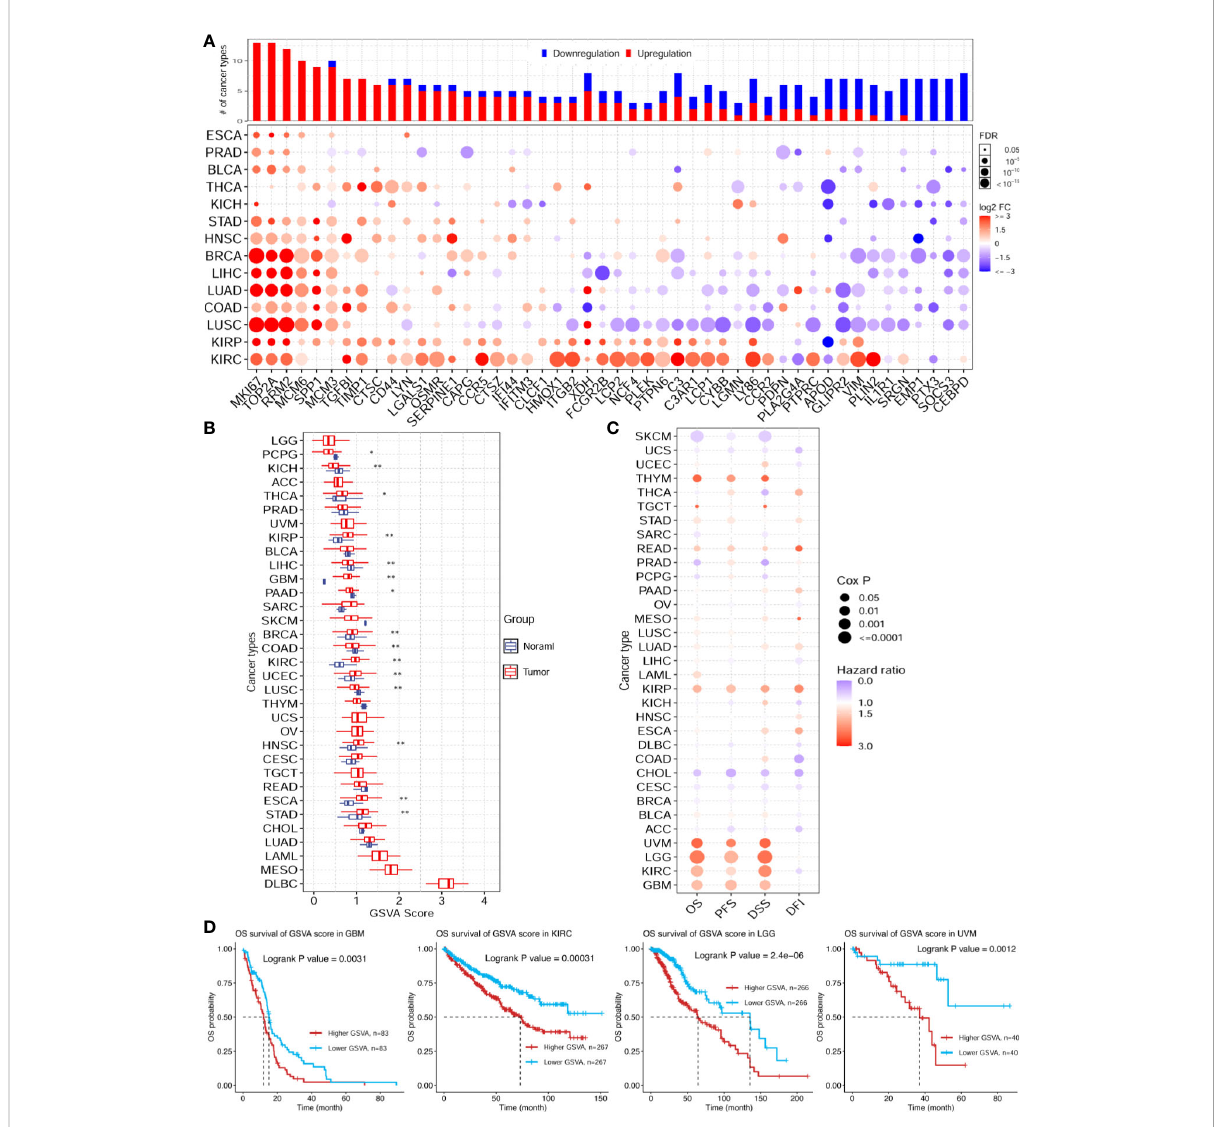
FIGURE 6 Pan-cancer genomic and prognostic analyses of the ischemic injury-associated genes. (A) Upregulation ( red ) and downregulation ( blue ) patterns of the ischemic injury-associated gene sets across different cancer types ( y -axis) compared to paired normal samples. The x -axis represents the 50 core brain ischemic injury-associated genes. The color intensity indicates the fold change, while the point size indicates the signi fi cance of the p -value. Upper bars show the frequency of cancer types, with upregulation ( red ) and downregulation ( blue ) for each brain ischemic injury- related gene. (B) Gene set variation analysis (GSVA) scores of the ischemic injury-associated gene set in each cancer type ( n = 3). * p < 0.05, ** p < 0.01. (C) Expression of the ischemic injury-associated genes correlated with the overall survival (OS), progression-free survival (PFS), disease-speci fi c survival (DSS), and disease-free survival (DFI) in various cancers from The Cancer Genome Atlas (TCGA). (D) Kaplan – Meier curves showing the OS of the ischemic injury-related gene sets analyzed in glioblastoma multiforme (GBM), kidney renal clear cell carcinoma (KIRC), brain lower grade glioma (LGG), and uveal melanoma (UVM). BC , control group for the uninjured brain; B2B and B6B , brain samples of the second and sixth days after brain photothrombosis (PT); SC , control group for the uninjured skull; S2S and S4S , skull samples of the second and fourth days after skull PT; B2S and B6S , skull samples of the second and sixth days after brain PT; S2B and S4B , brain samples of the second and fourth days after skull